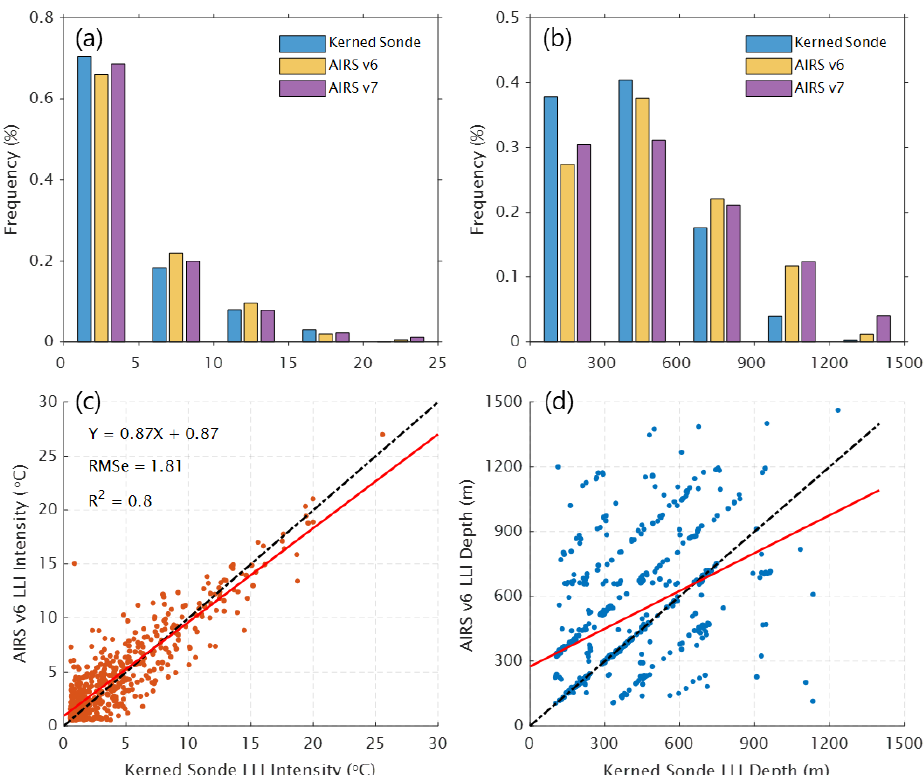
Figure 8. Comparisons of LLI depths and intensities. The frequency distributions of LLI intensity and depth are shown in panels ( a , b ) using bin sizes of 5 °C and 300 m, respectively. The correlations of LLI intensities and depths between the AIRS v6 and kerned sonde profiles are shown in panels ( c , d ). The identity (1:1) line is shown in a black chain line, and a line representing linear regression is shown in red. Regression statistics are also shown.